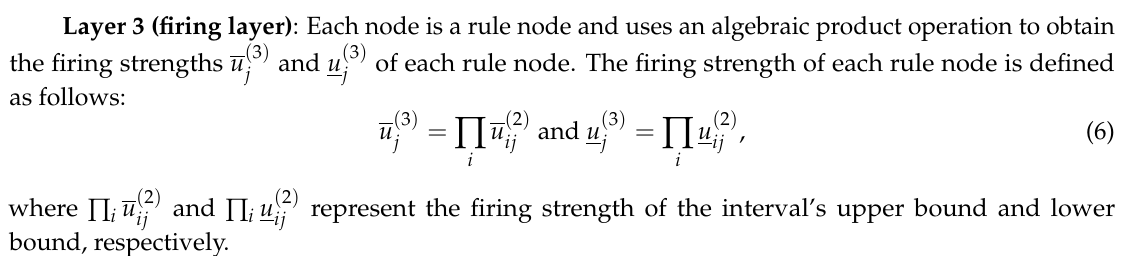
Figure 3. Interval type-2 fuzzy sets.